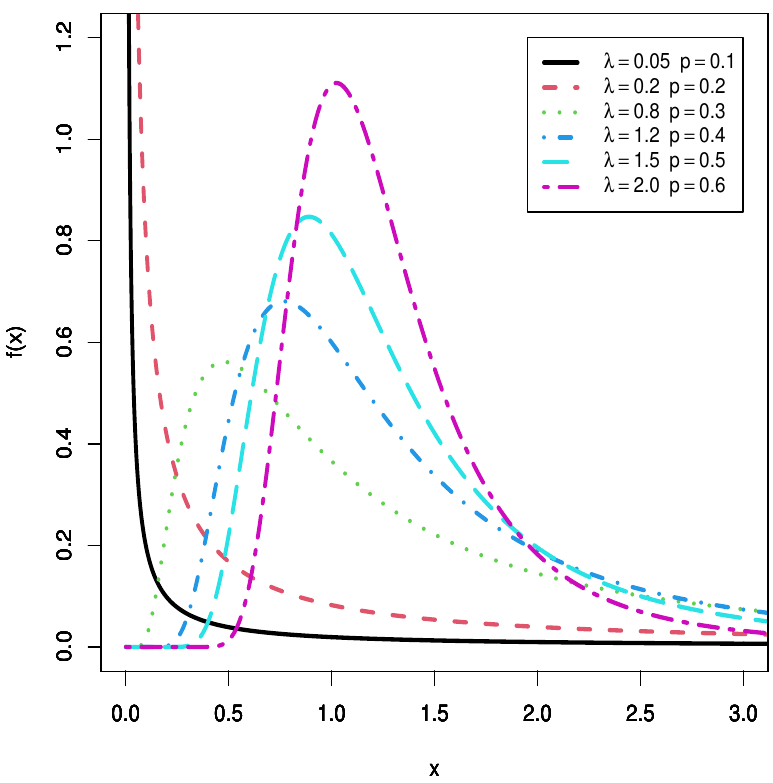
Figure 1. Different shapes of pdf for FB distribution at β = 1.5 and n = 5.